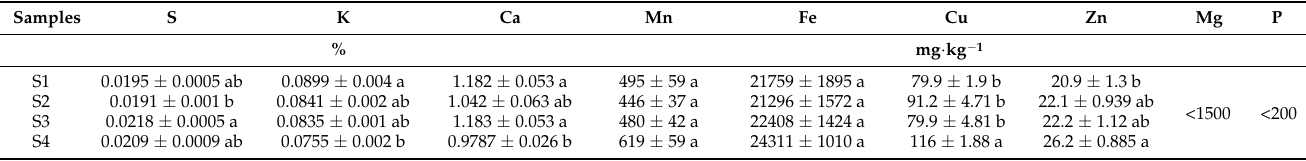
Table 2. Soil analyses (samples collected at depth of 0–30 cm) of Triticum aestivum L. experimental field’s mineral quantification of S, K, Ca, Mn, Fe, Cu, Zn ( n = 9). Letters a, b indicate significant differences of each parameter, considering different samples (statistical analysis using the single-factor ANOVA test, p < 0.05). Mg and P presented values lower than the detection limit of the